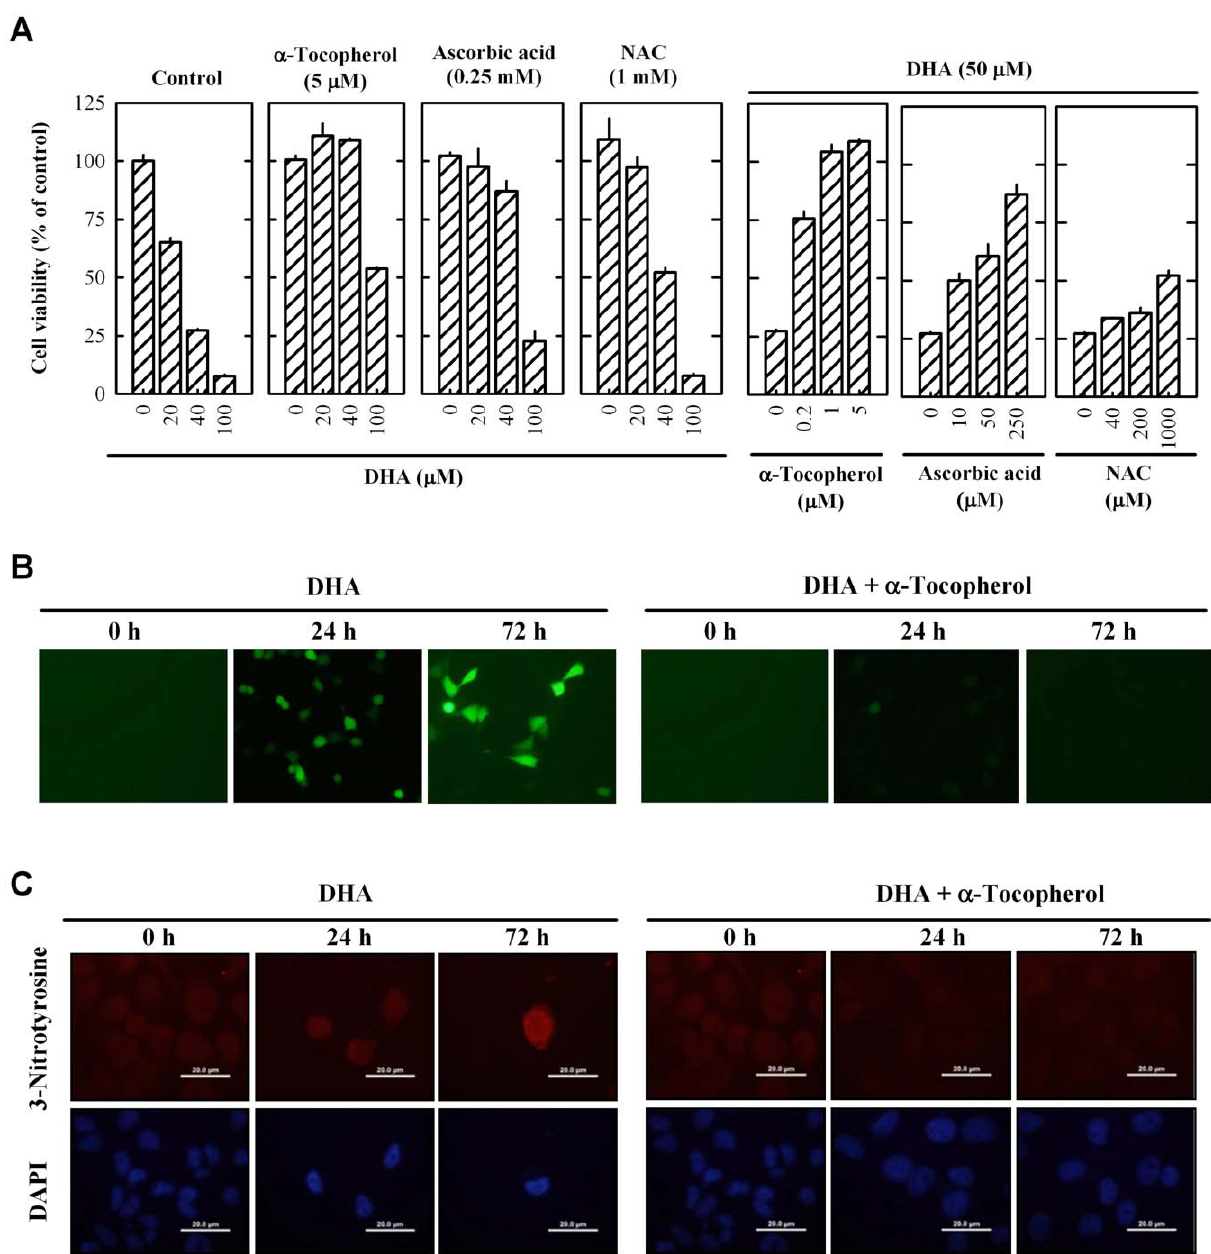
Figure 3. DHA induces ROS accumulation in MCF-7 cells. ( A ) Cell viability (MTT assay) of MCF-7 cells treated with different concentrations of a - tocoperol,ascorbicacid,orN-acetylcysteine(NAC)andDHA.Eachvalueis themean 6 S.E.(n=6). ( B ) ROSaccumulationmeasuredbyH 2 -DCF-DAstainingof MCF-7 cells treated with 25 m M DHA ortogether with1 m M a -tocoperol for indicated time periods. Thepictures were taken under a fluorescent microscope atthe 100 6 magnification. ( C ) 3-Nitrotyrosine staining ofMCF-7cells treatedwith25 m MDHAor togetherwith1 m M a -tocoperol forindicatedtime periods. The pictures were taken under a fluorescent microscope at the 400 6 magnification. Each value is the mean 6 S.E. (n=3).